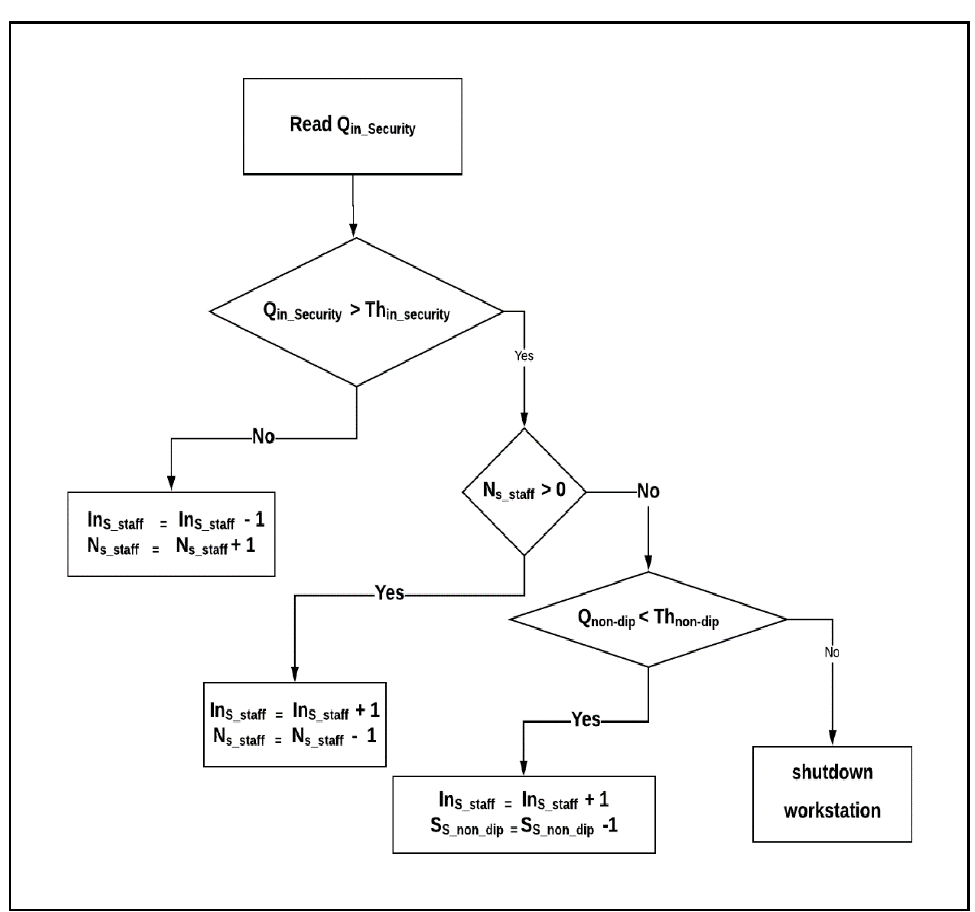
Figure 7. Phase two of the algorithmic approach for security resource allocation management.